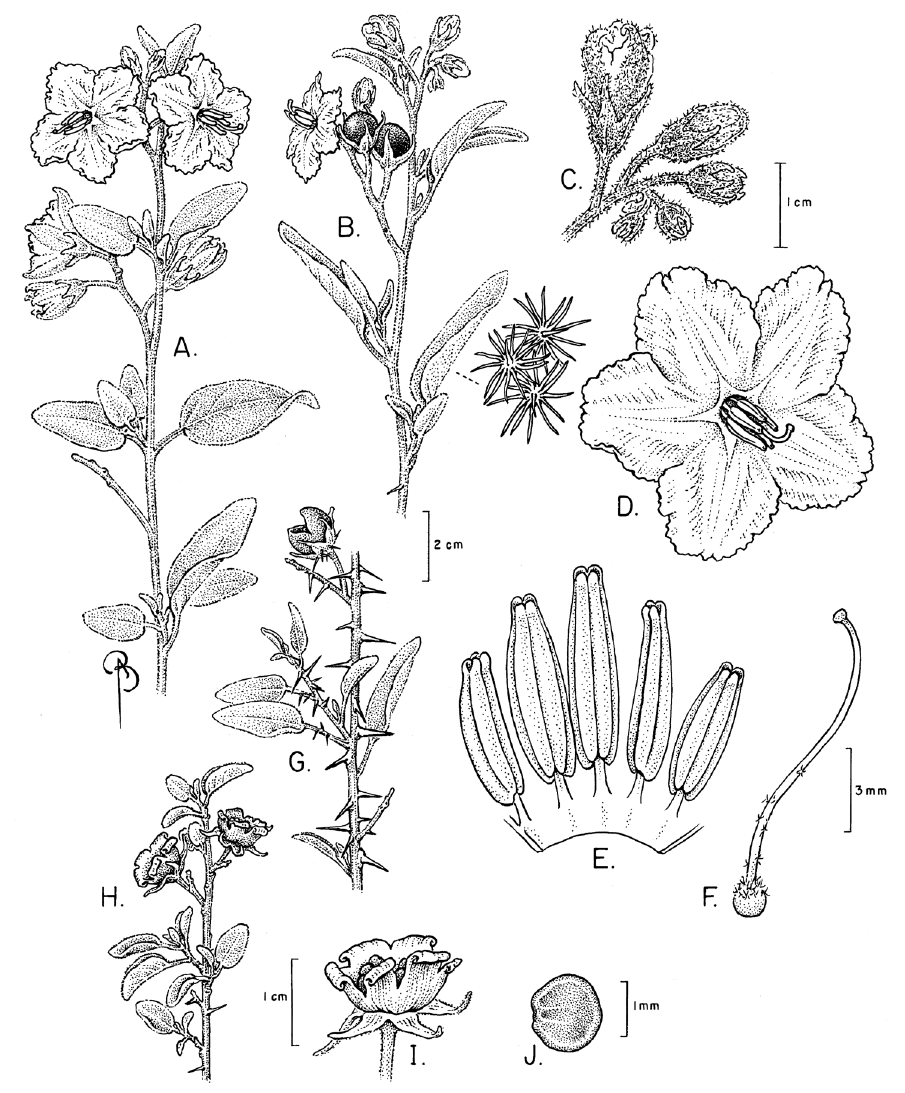
Figure 7. Solanum hindsianum Benth. A Flowering branch B Fruiting branch showing stellate trichomes C Buds D Corolla E Anthers F Gynoecium G Fruiting branch of prickly individual with broad based stem prickles H Fruiting branch with mature berries I Mature berry with irregular dehiscence J Seed. Drawn by Bobbi Angell. A, D–F from Halse s.n. (NY00854332) B, C from Sousa-Peña 79 (NY00751522); G from Orcutt 1339 (NY00751531); H, J from Daniel 1856 (NY00751517).